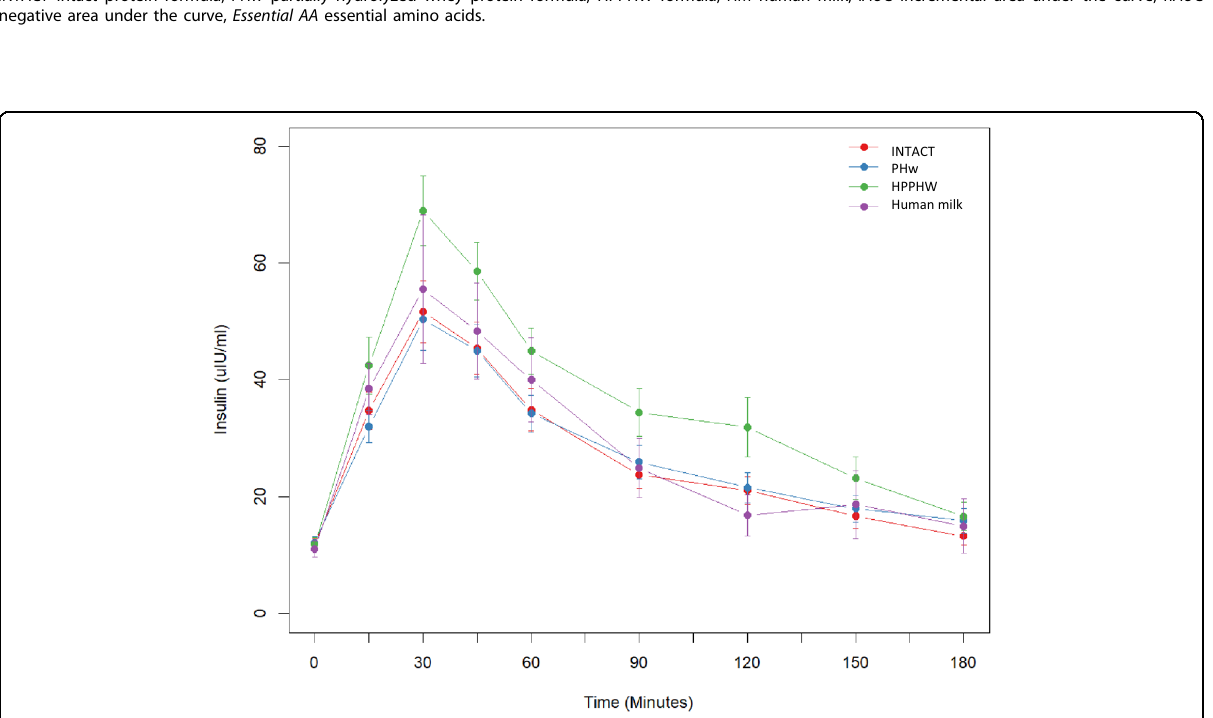
Fig. 2 Insulin response to infant formulas and human milk overtime in healthy subjects from baseline and every 30 min for 180 min post- ingestion. Red: INTACT ( n = 29), intact protein formula; Blue: PHw ( n = 29), partially hydrolyzed whey protein formula; Green: HPPHW ( n = 28), higher protein PHw formula; Violet: Human milk ( n = 8). Data are mean ±